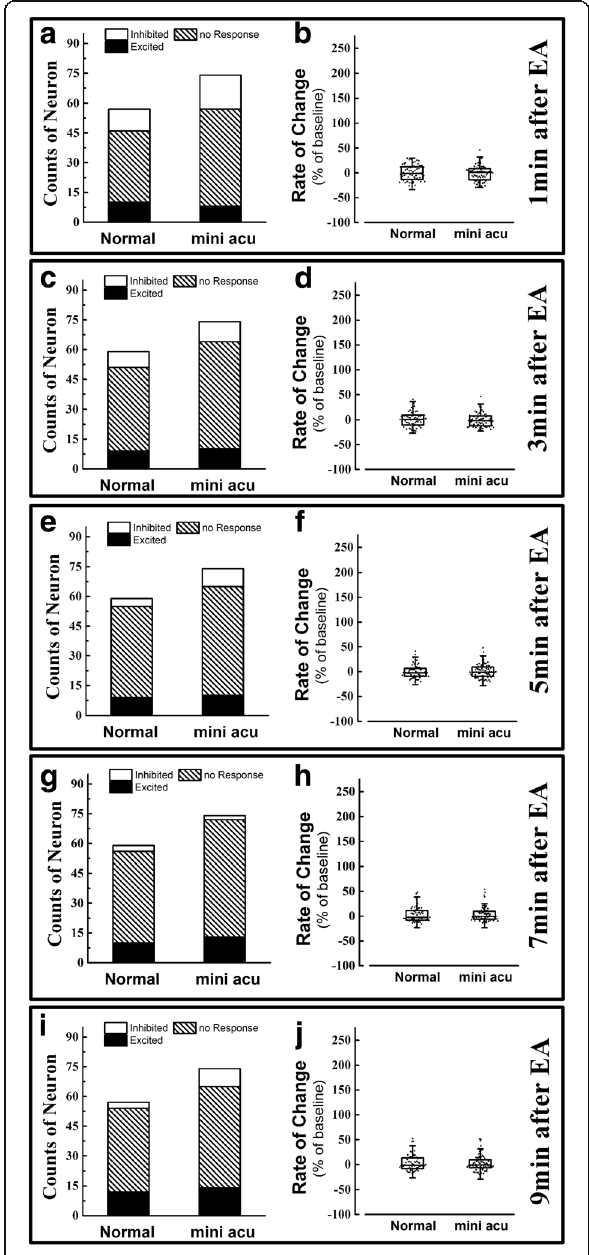
Fig. 4 The distribution of three types of neurons and the rate of change for spike frequency change of NTS neurons after minimal acupuncture stimulated at ST 36 and ST 25. The population of three types neuron in NTS at 1 min ( a ), 3 min ( c ), 5 min ( e ), 7 min ( g ) and 9 min ( i ) after minimal acupuncture administered. And the rate of change of spike frequency in NTS neurons at 1 min ( b ), 3 min ( d ), 5 min ( f ), 7 min ( h ) and 9 min ( j ) after minimal acupuncture administered. Results of the number of three types of neurons are real numbers and the rates of change of spike frequency are mean, quartile and standard deviation. n = 5. mini acu means minimal